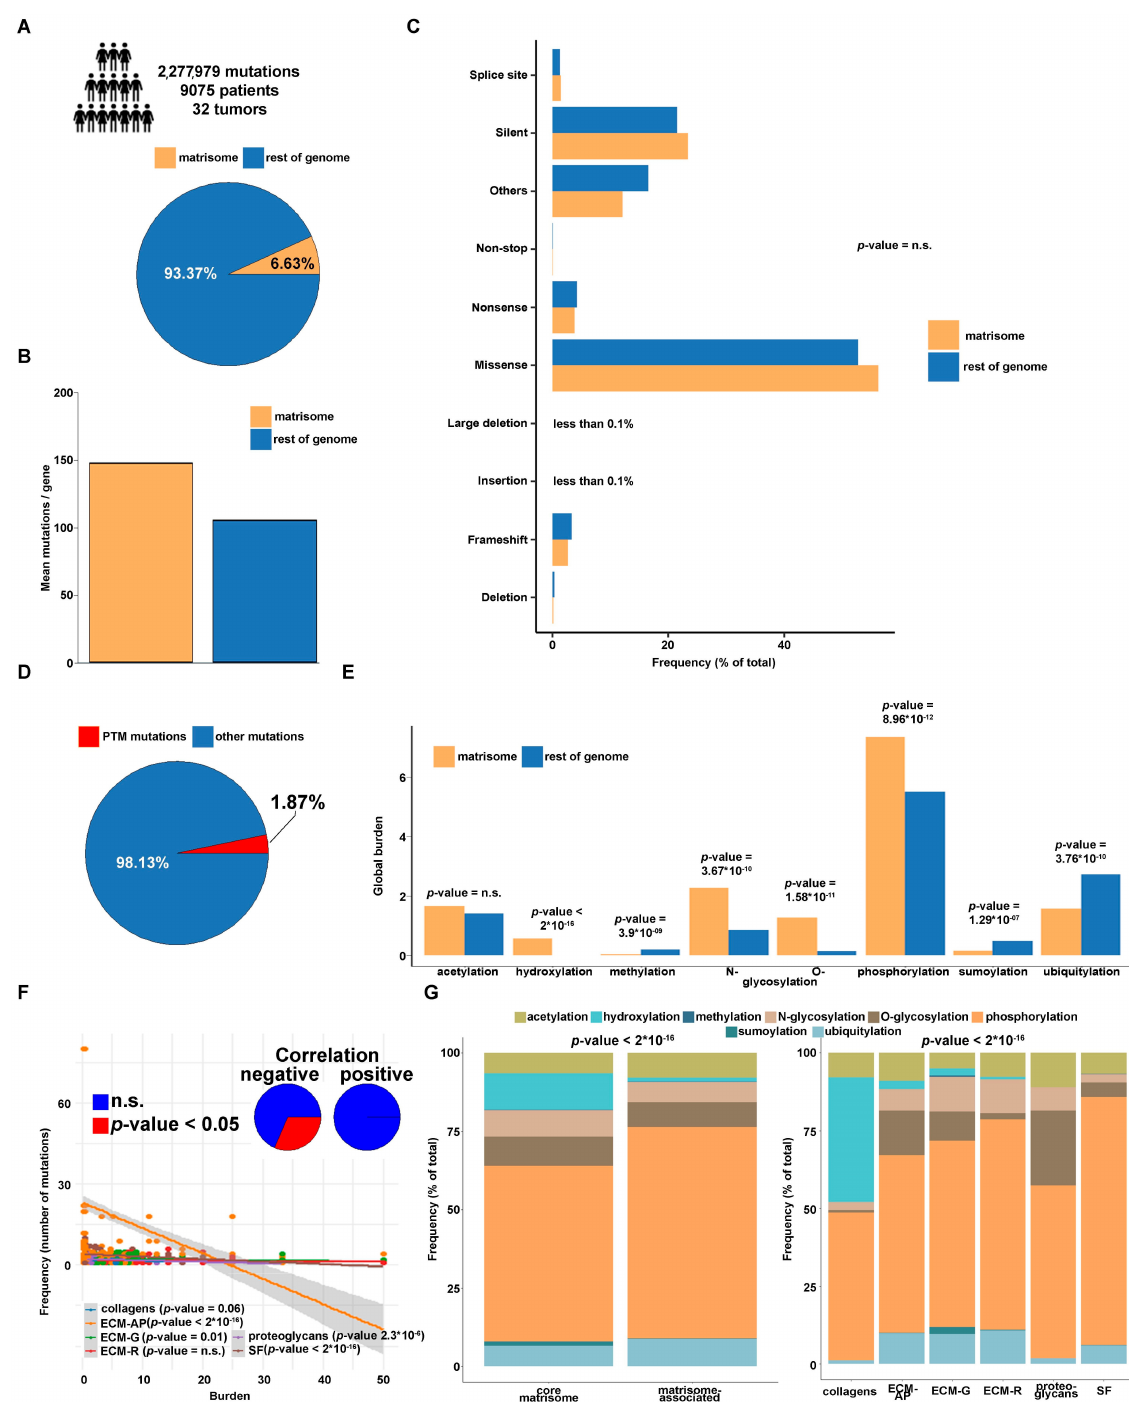
Figure 1. The genomic landscape of PTM-disrupting mutations (PTM mut ) in the tumor matrisome and in the rest of the genome. Dimensions of the analysis ( A ) and comparison between the tumor matrisome and rest of the tumor genome for overall mutation frequency ( B ) and type of mutation ( C ). PTM mut are a minority of all matrisome mutations ( D ) with significant enrichments or depletions of PTM types affected ( E ). The amount of PTM mut across tumors and divided by matrisome family ( F ) is negatively correlated with preservation of the PTM mut (indicating poor preservation of a given PTM mut in multiple patients (or cancer types) and ( G ) varies considerably across the different types of PTM investigated. Abbreviations: n.s., not significant; ECM-AP, ECM-affiliated proteins; ECM-G, ECM glycoproteins; ECM-R, ECM regulators; SF, secreted factors. p -values are from Chi-square